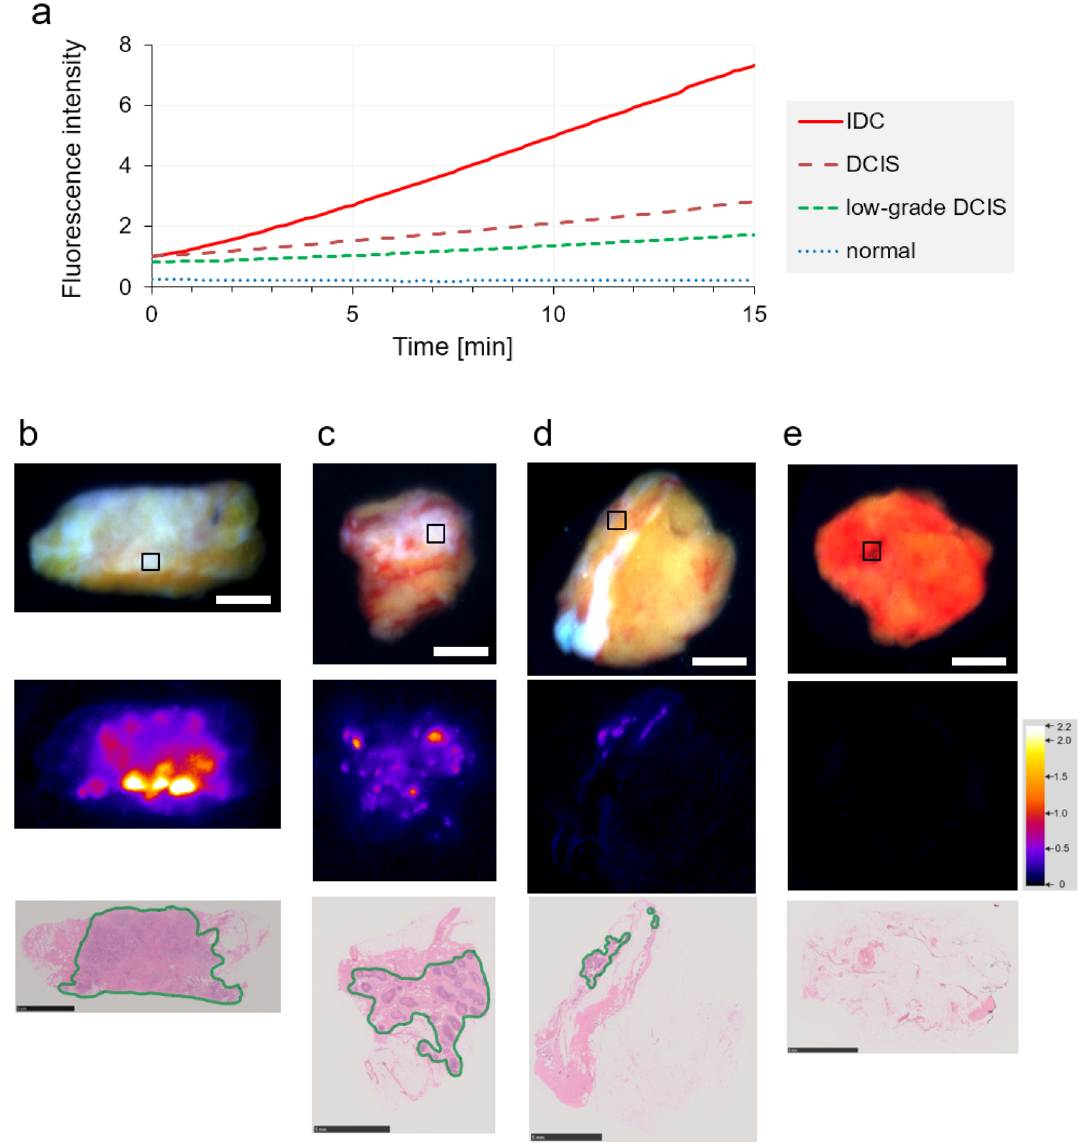
Figure 2. Representative examples of fluorescence intensity changes . A representative example of each IDC, DCIS, low-grade DCIS, and normal breast tissue (N = 1) is indicated. ( a ) Fluorescence intensity changes in the areas shown by the squares in the visible light images in panels ( b – e ). ( b – e ) Visible light images, 5 min FI images with pseudocolor, and HE-stained images of various samples. The green lines indicate areas of malignant cells. ( b ) Invasive ductal carcinoma. ( c ) Middle/high-grade DCIS. ( d ) Low-grade DCIS. ( e ) Normal breast tissue, including normal mammary glands. The scale bars indicate 5